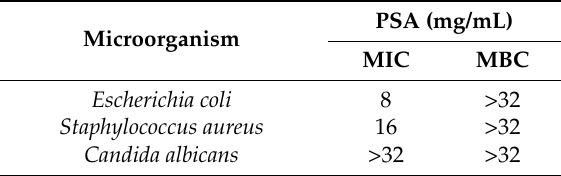
Table 3. Antibacterial and antifungal activities of